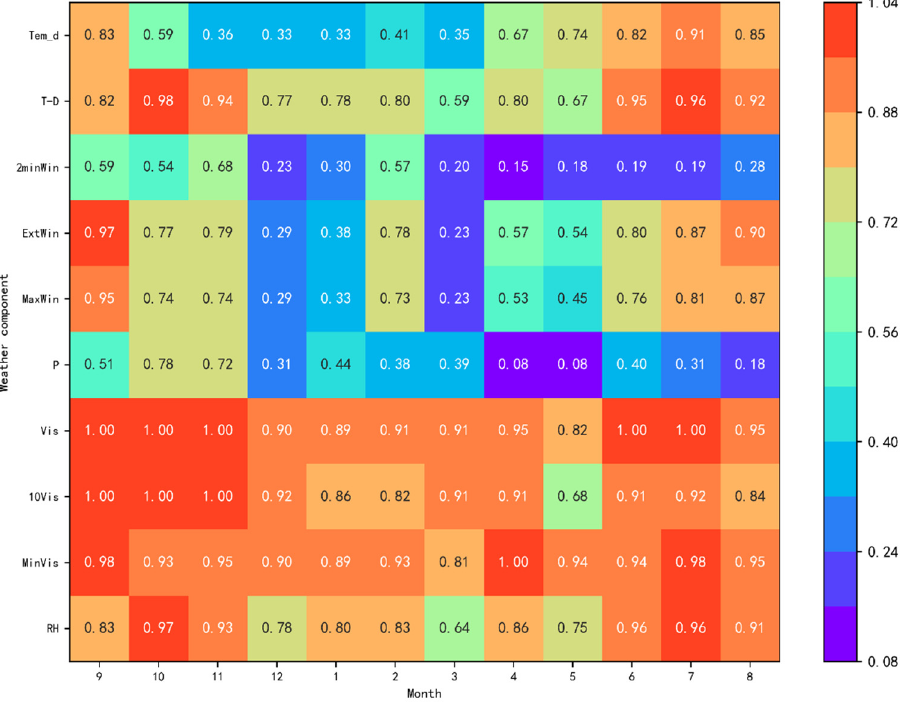
Figure 4. Proportions of stations passing the significance tests for the monthly average correlation coefficient between each reference weather component and hourly precipitation in Hainan Province,